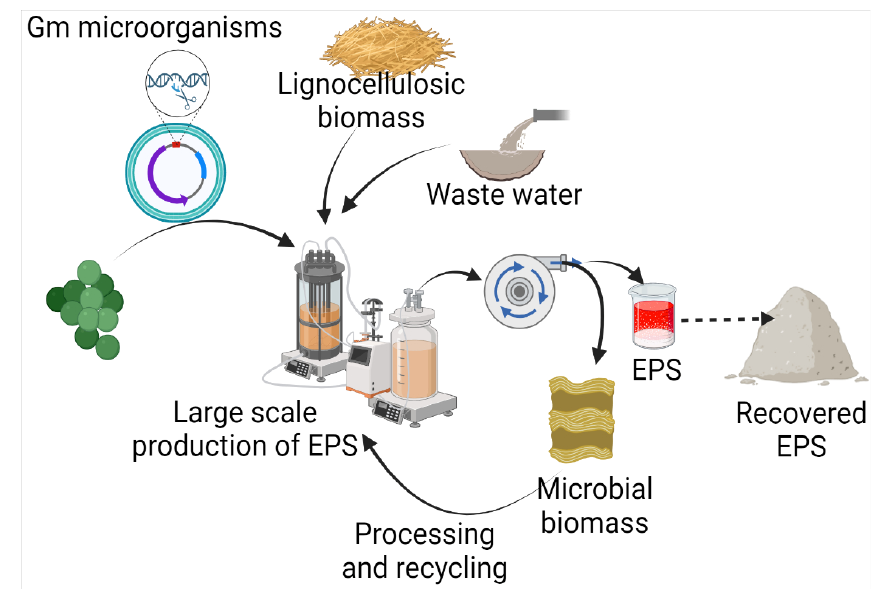
Figure 2. Microbial production of EPS using waste, and its recovery.